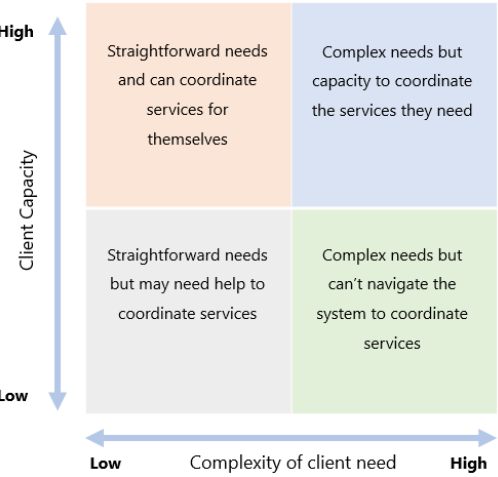
Figure 1. Matrix of complexity, client needs and capacity. (Permission to reproduce granted by the NZ Productivity Commission).